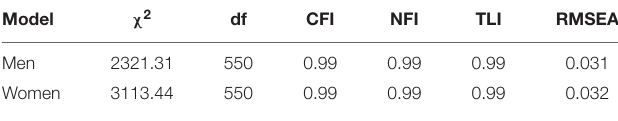
TABLE 4 | The goodness-of-fit indices for men and women mediating